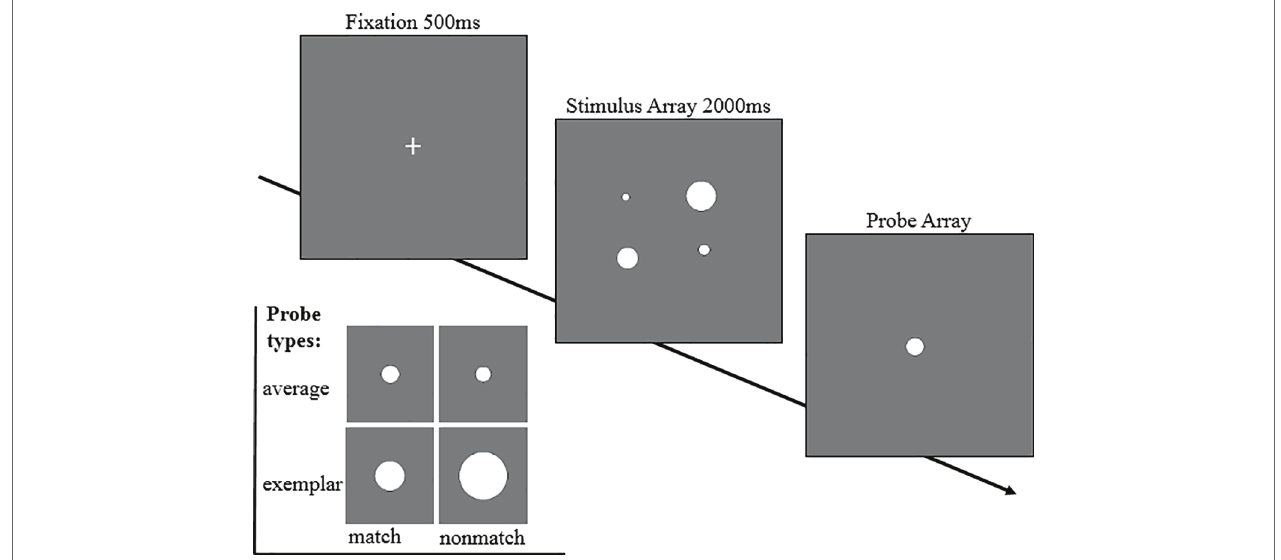
FIGURE 3 | A schematic presentation of ensemble coding task and probe type used in Experiment 2. Each trial began with a fixation (500 ms) and a stimulus array containing four heterogeneous dots (2,000 m). Next, in the probe array, participants had to indicate whether the probe dot was “present” or “absent” in the prior array based on the size of the dot by pressing “F” (present) or “J” (absent) key. The probe dot could be either a dot with size equal to the mean size of the preceding set (match average), a dot with size was the mean size of another stimulus set (nonmatch average), a dot of the preceding set (match exemplar), or a dot of another set (nonmatch